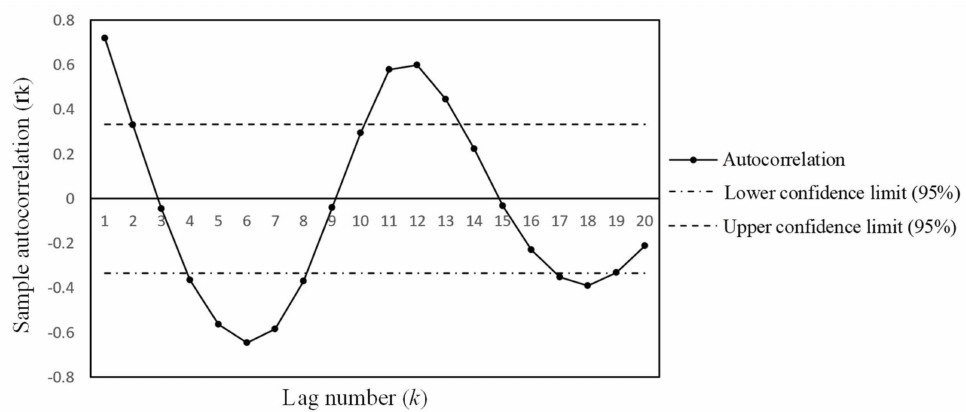
Figure 5. Results of the sample autocorrelation